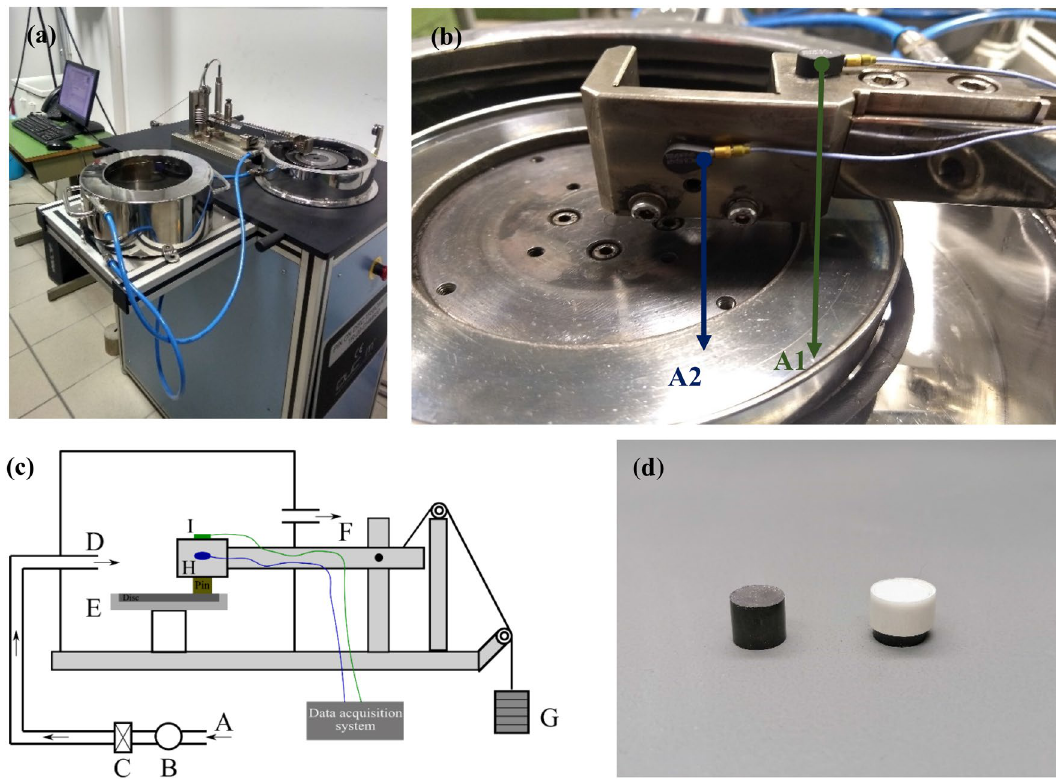
Figure 6. ( a ) PoD tribometer; ( b ) Shear accelerometer positions; ( c ) Testing apparatus setup (A) Ambient air, (B) Fan, (C) HEPA filter, (D) Air introduced in the chamber, (E) Disc/Counterface, (F) Air outlet to the OPS, (G) Weights, (H) & (I) Shear accelerometers attached to the pin holder; ( d ) A typical example of pins with and without the rubber